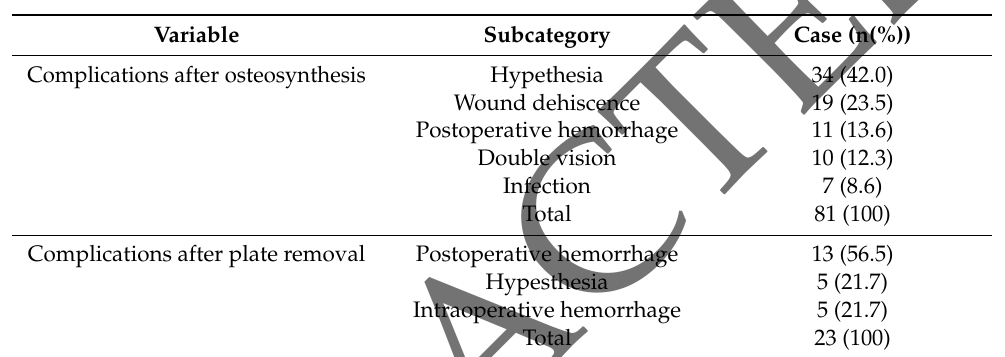
Table 8. Complications after osteosynthesis in correlation to gender, age group, and nicotine and alcohol abuse. All results were calculated by the Pearson’s Chi-square test. The calculation of the correlation of the age group had more degrees of freedom. The result of this Chi-square test might not be as powerful as the other results. Totals of the percentages may not be exactly 100% because of